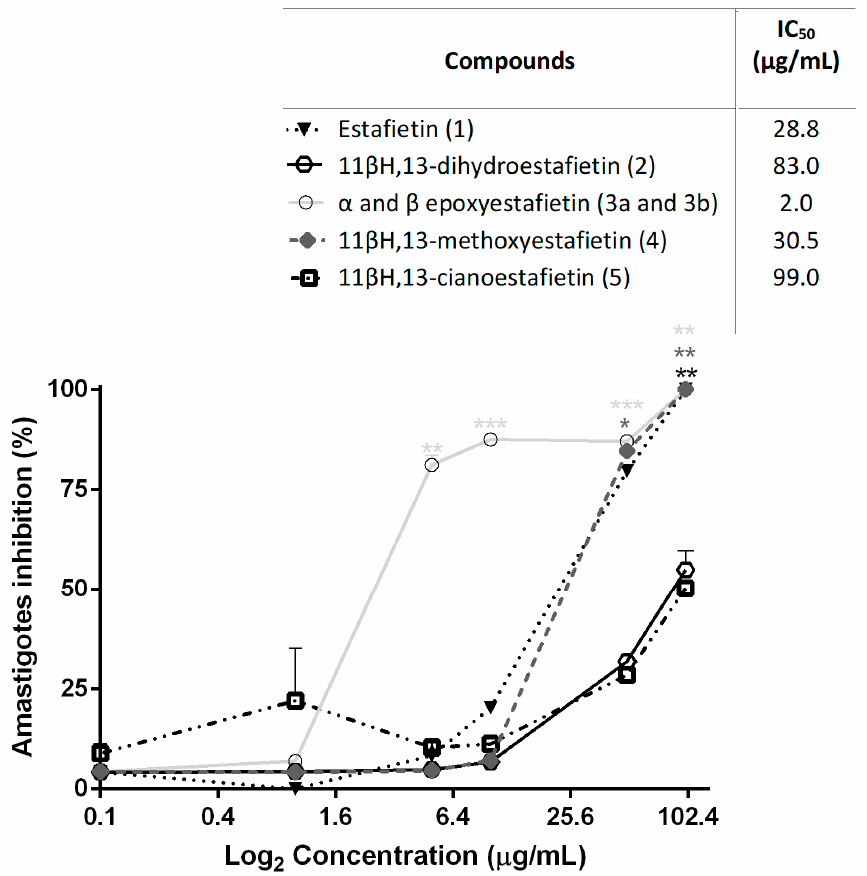
Figure 3. Inhibition of T. cruzi amastigotes replication by estafietin ( 1 ) and estafietin derivatives ( 2 – 5 ). Mammalian cells (5 × 10 3 cells/well) were seeded in 96-well plates and infected 24 h later with transfected trypomastigotes expressing β -galactosidase. After 24 h of co-culture, plates were washed and compounds were added at 0–100 µg/mL in 150 µL medium. On day 6 post-infection, the assays were developed by the addition of CPRG (100 mM) and Nonidet P-40 (1%). Plates were incubated for 6 h and the optical density was read at 570 nm. Infected untreated mammalian cells were used as 100% infection control. The percentage of inhibition was calculated as 100 − {[(Absorbance of treated infected cells)/(Absorbance of untreated infected cells)] × 100}. Symbols represent mean ± SEM. Each treatment was compared to controls: parasites incubated with culture medium only. * p < 0.05, ** p < 0.01 and *** p < 0.005.